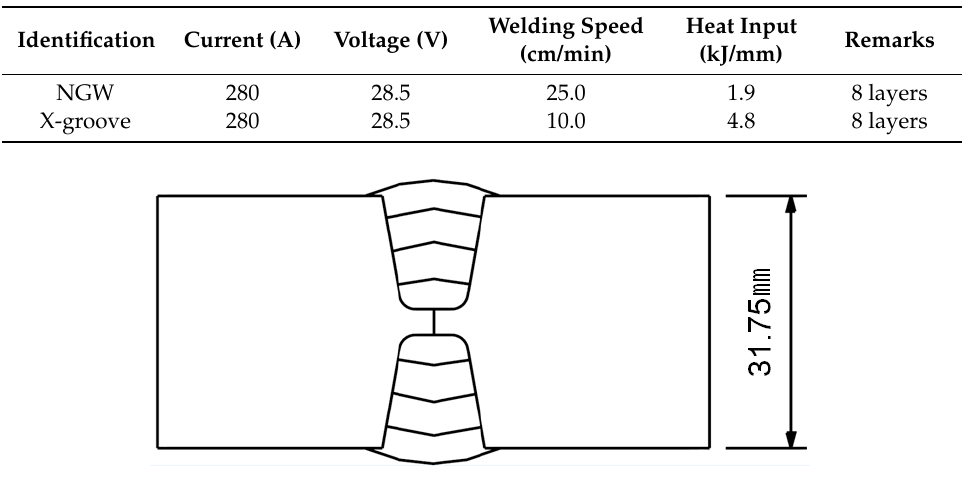
Figure 1. Geometry of NGW weldment and welding deposition sequence. NGW: narrow gap welding.